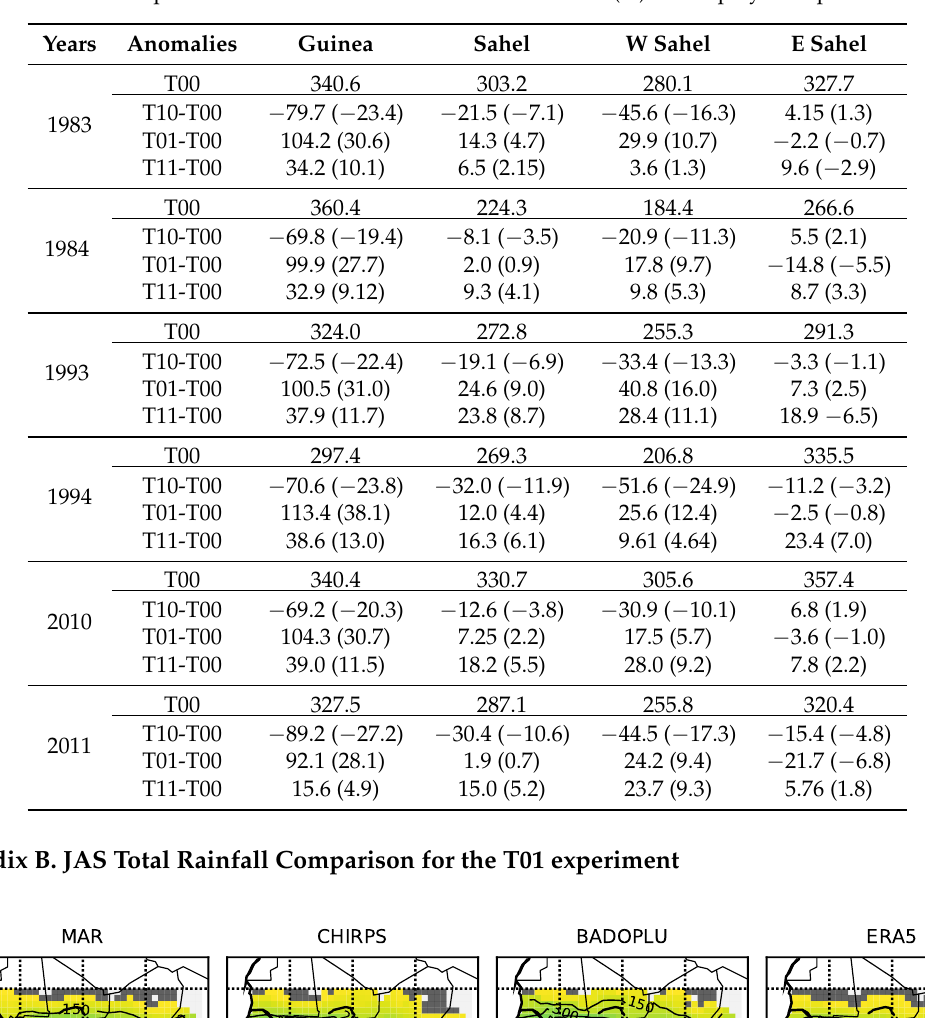
Table A1. JAS cumulative rainfall (mm) for the control simulation (T00) and sensitivity experiment anomalies with respect to the control simulation. Relative values (%) are displayed in parenthesis.